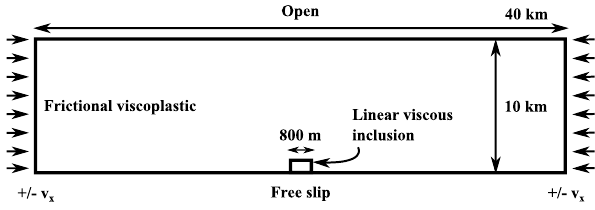
Table 4. The brick benchmark model parameters.